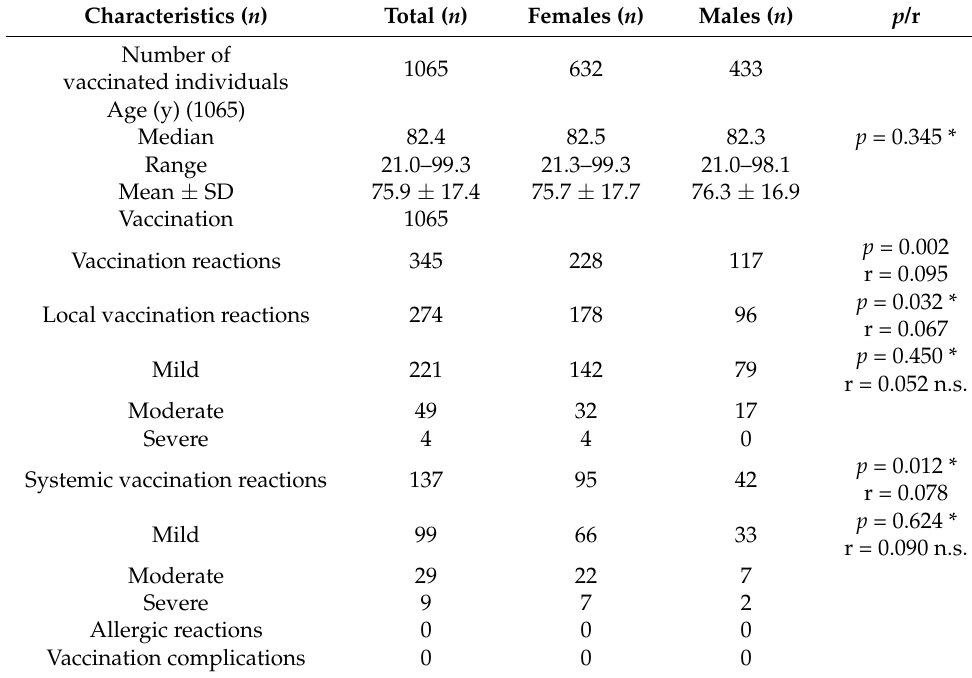
Table 1. Gender-graded vaccination